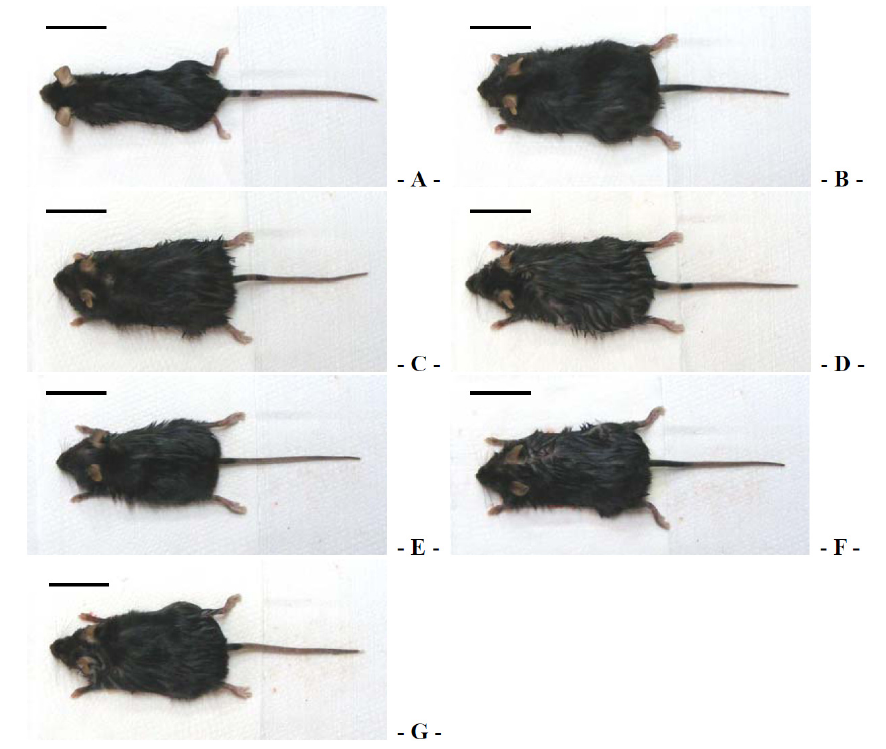
Figure 2. Representative gross body mass images, taken from intact normoglycemic or db/db Mice at sacrifice. ( A ) Intact control mouse; ( B ) db control mouse; ( C ) metformin 250 mg/kg treated db mouse; ( D ) GT 400 mg/kg treated db mouse; ( E ) fGT 400 mg/kg treated db mouse; ( F ) fGT 200 mg/kg treated db mouse; ( G ) fGT 100 mg/kg treated db mouse. GT, Green tea aqueous lyophilized extracts; fGT, Aquilariae Lignum-fermented green tea aqueous lyophilized extracts. Scale bar = 33